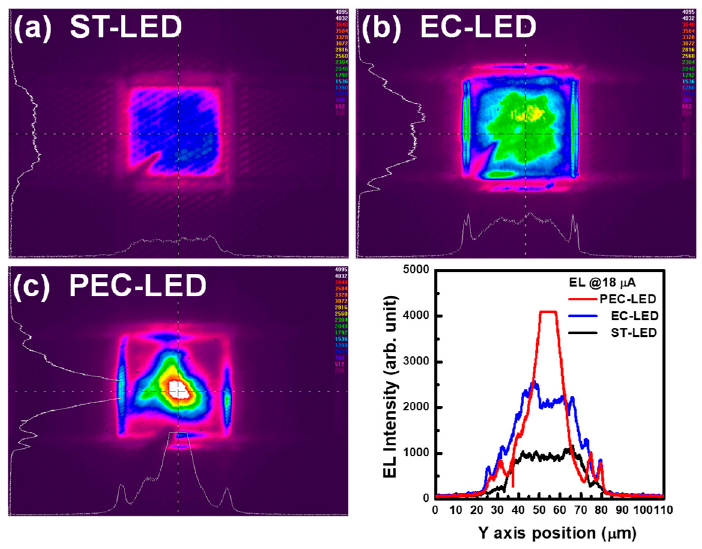
Figure 3. The EL emission images of ( a ) ST-LED, ( b ) EC-LED, and ( c ) PEC-LED observed using a beam profiler. The line intensity profile of the LED samples were measured at an 18 µA operation current (see bottom right Figure).